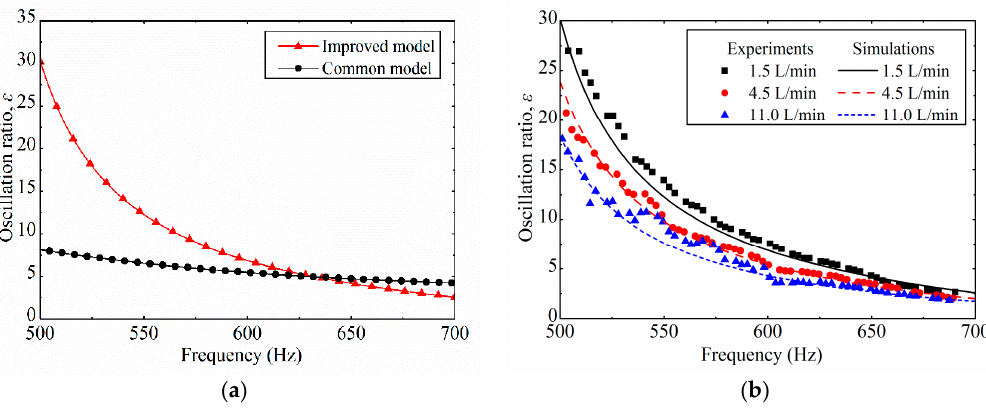
Figure 6. Comparison of simulated and experimental results. ( a ) Comparison of the improved and common model and ( b ) comparison of the improved model and experimental results.